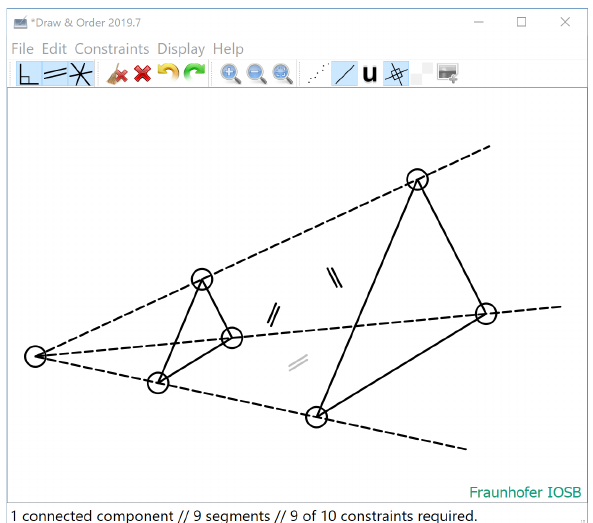
Figure 12. Desargues’s theorem in its affine form: The sides of the two triangles are pairwise parallel. Nine of the ten constraints are